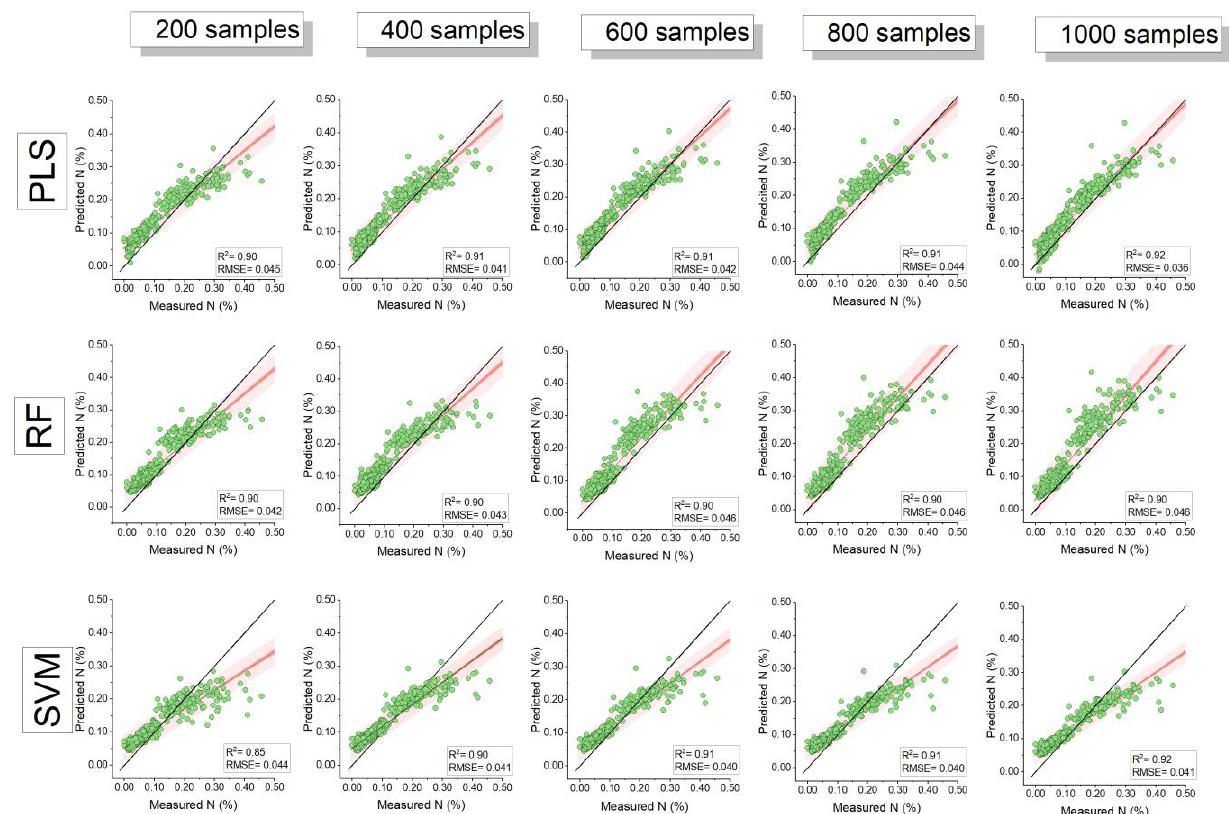
Figure 6. Comparison between the soil nitrogen (N) values measured by elemental analyses and the MID predicted values using the three different training algorithms, partial least squares (PLS), random forest (RF) and support vector machine (SVM). The validation included and external test set comprised of 612 observations. For each sample size, the graphs represent an average of the five calibrations randomly extracted from the total dataset (n = 1000 samples).